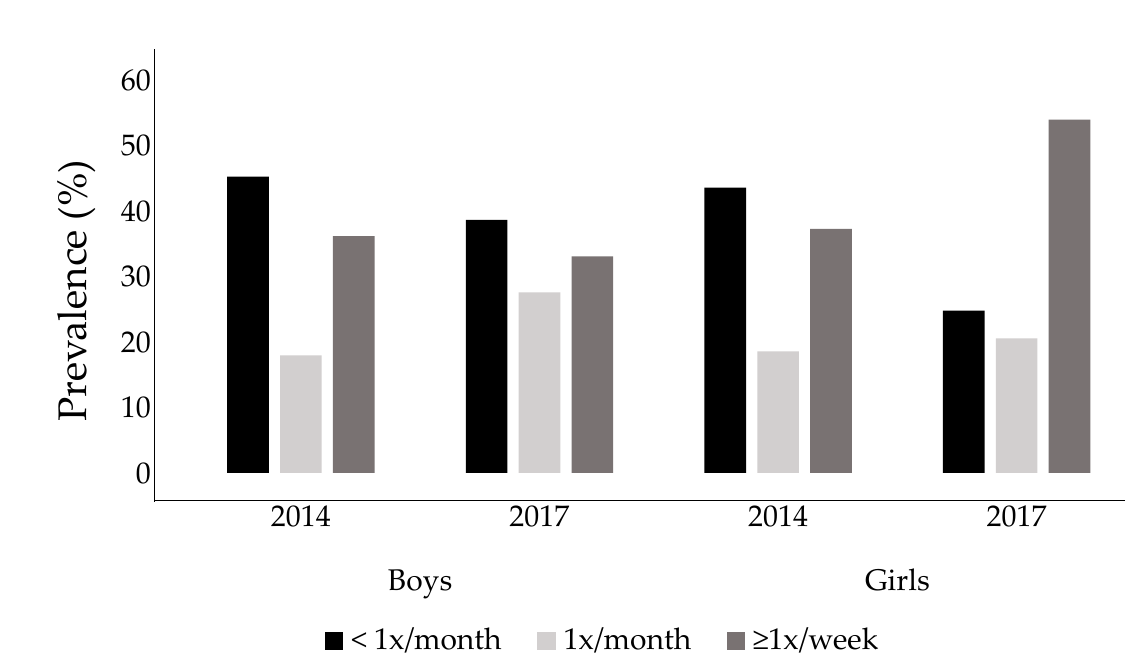
Figure 3. Back pain frequency in two follow-up assessments (2014 and 2017) stratified by sex.